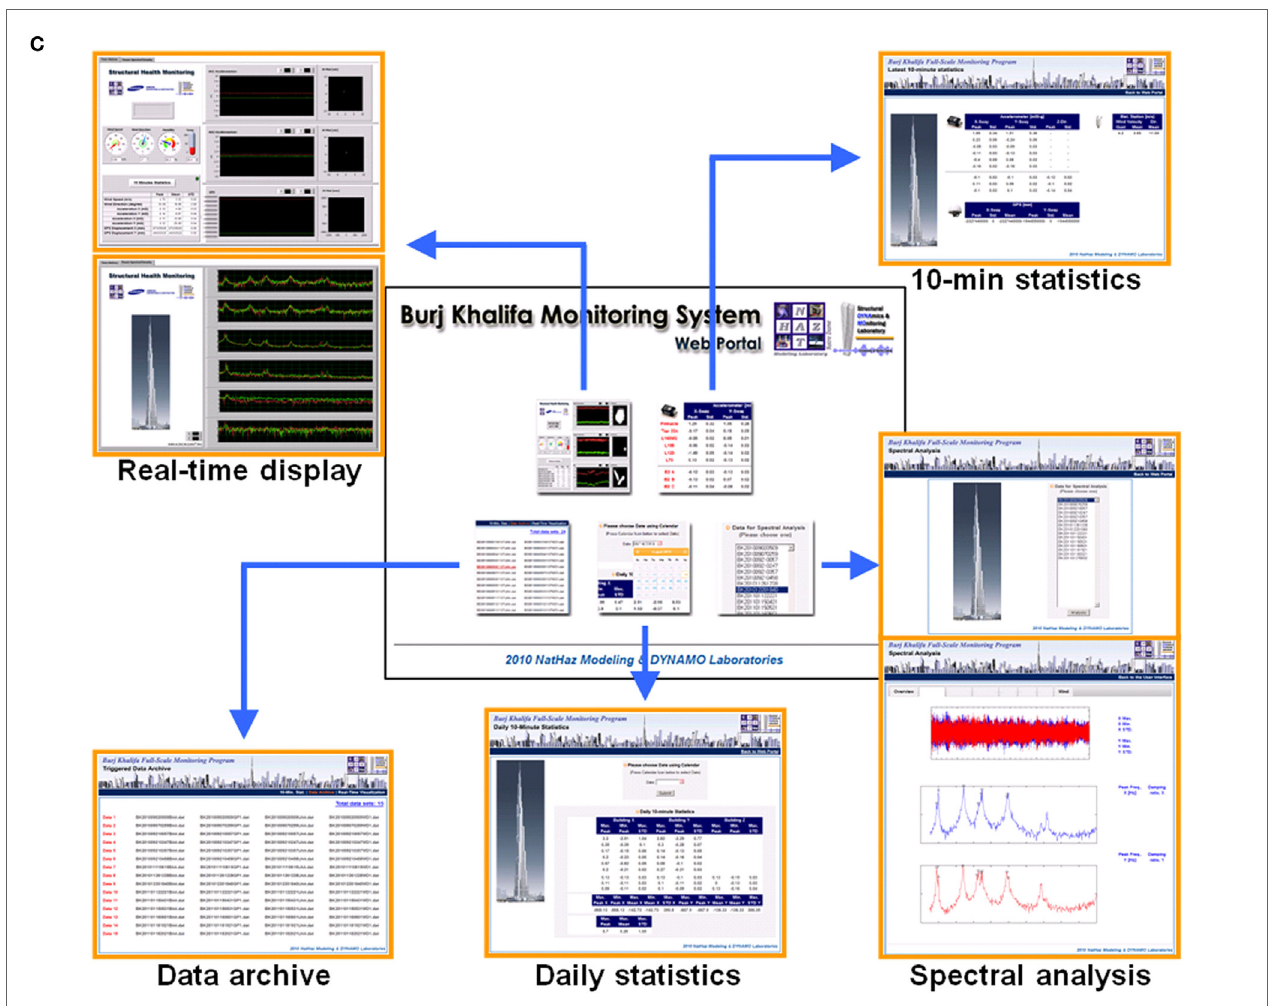
FigUre 14 | (a) Database query interface in the Chicago project. (B) Analyzed data display interface in the Chicago project. (c) Cyber-based e-modules in the SmartSync